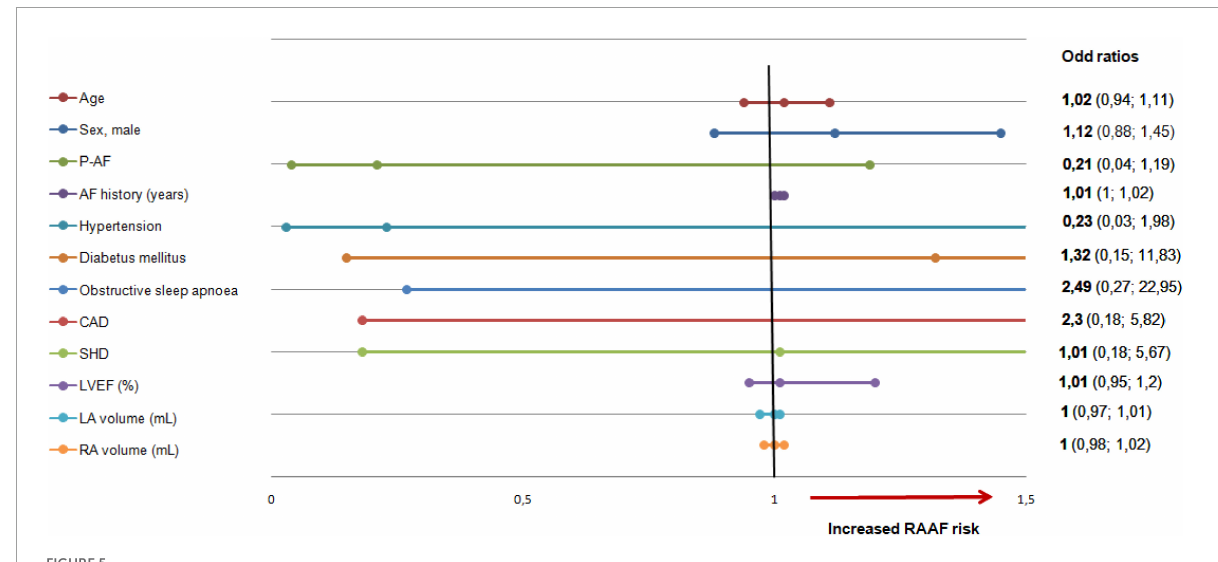
FIGURE5 Right atrial appendage firing predictive factors. Clinical factors tested for RAAF. None of the studied factors were significantly associated with RAAF. LA, left atrium; RA, right atrium, RAAF, right atrial appendage firing; AF, atrial fibrillation, CAD, coronary artery disease; SHD, structural heart disease; LVEF, left ventricular ejection